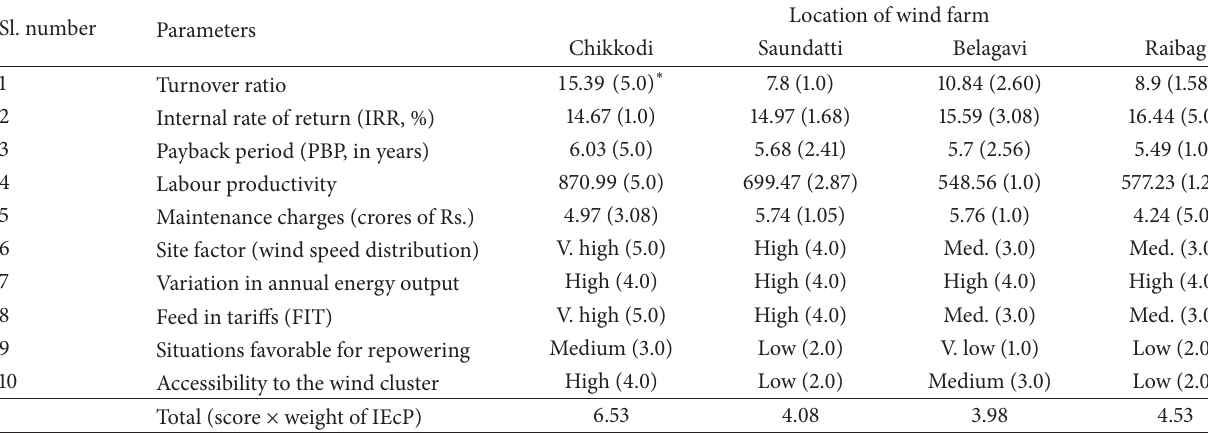
∗ Note : the number inside the parentheses indicates converted parameter on a 1–5